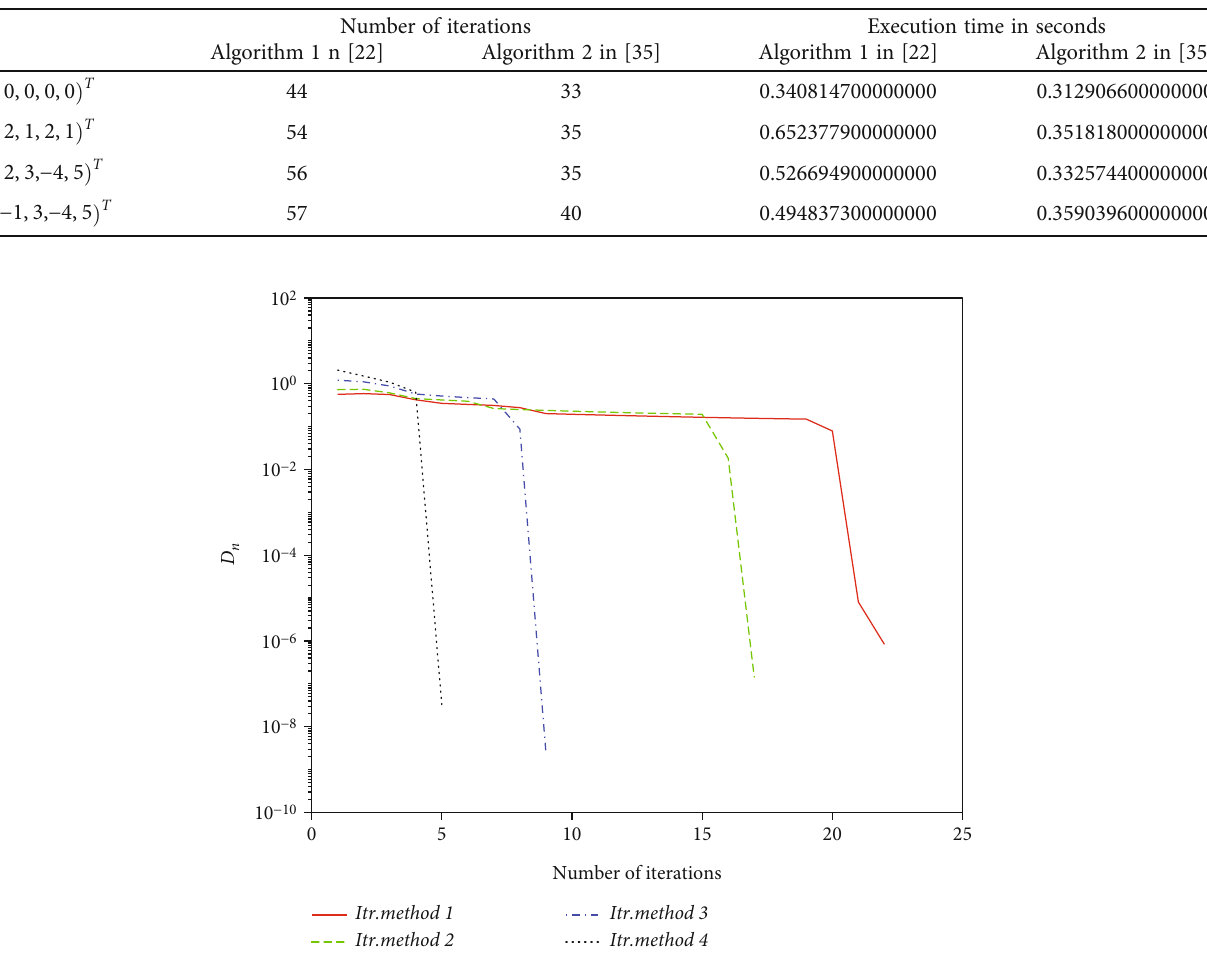
Table 2: All methods ’ numerical values for Figures 1 – 8.